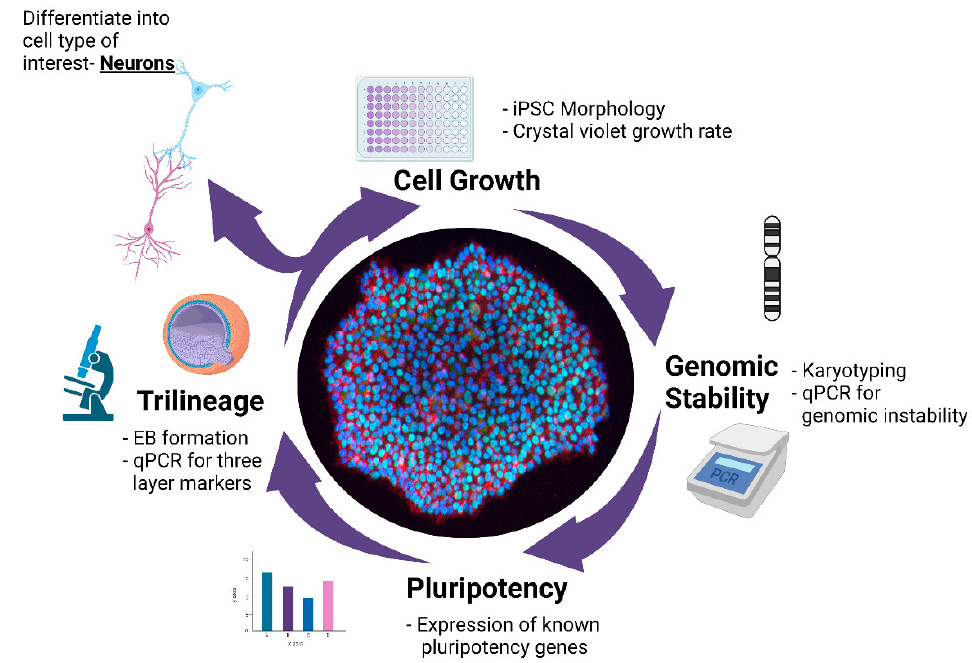
Figure 1. Multistep workflow for phenotyping of hiPSCs. Schematic representation of a multistep QC workflow for newly generated iPSCs to monitor morphology and proliferation, genomic integrity, pluripotency, and ability to form cells of the three germ layers.